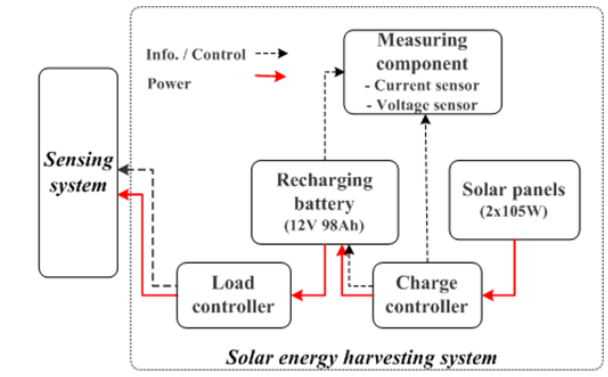
Figure 6. A typical store-and-use architecture for a solar-energy-harvesting